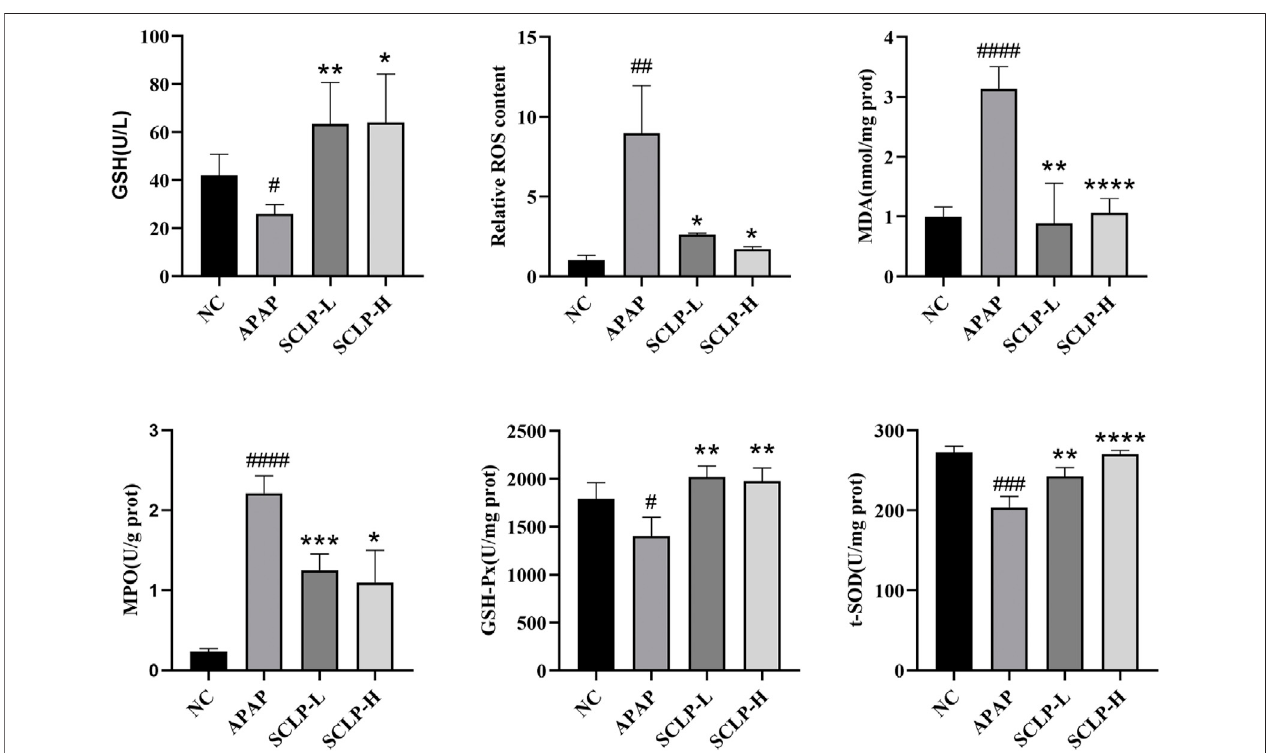
FIGURE 4 | SCLP alleviated liver oxidative stress in AILI model mice. Effects of SCLP on serum GSH (A) , liver ROS (B) , liver MDA (C) , liver MPO (D) , liver GSH-Px (E) ,livert-SOD (F) inAPAP-inducedmice.Dataarepresentedasthemean±S.D.( n =4). # p < 0.05, ## p < 0.01, ### p < 0.001, # ### p < 0.0001vs.NC.* p < 0.05,** p <